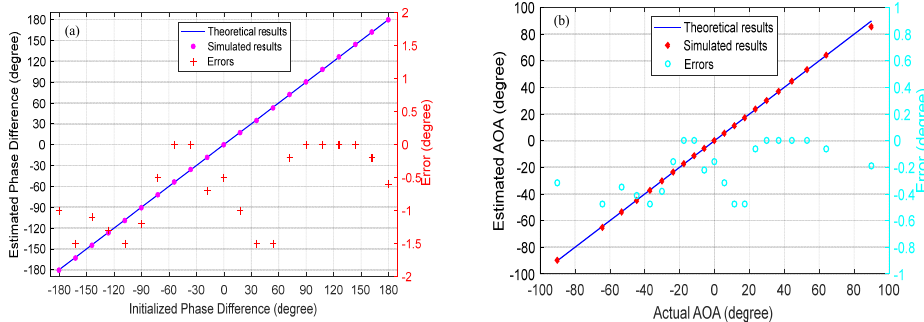
Figure 6. ( a ) Estimated phase difference (rose, dots) and the corresponding error (red, crosses) versus the ideal curve of initialized phase di ff erence from − 180° to 180°. ( b ) Estimated AOA (red, dots) and the corresponding error (cyan, circles) versus the ideal curve of actual AOA from − 90° to 90°.